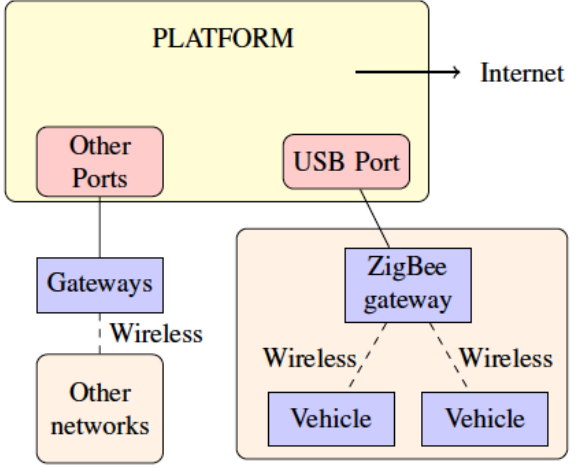
Figure 3. Block diagram of unified communication platform.